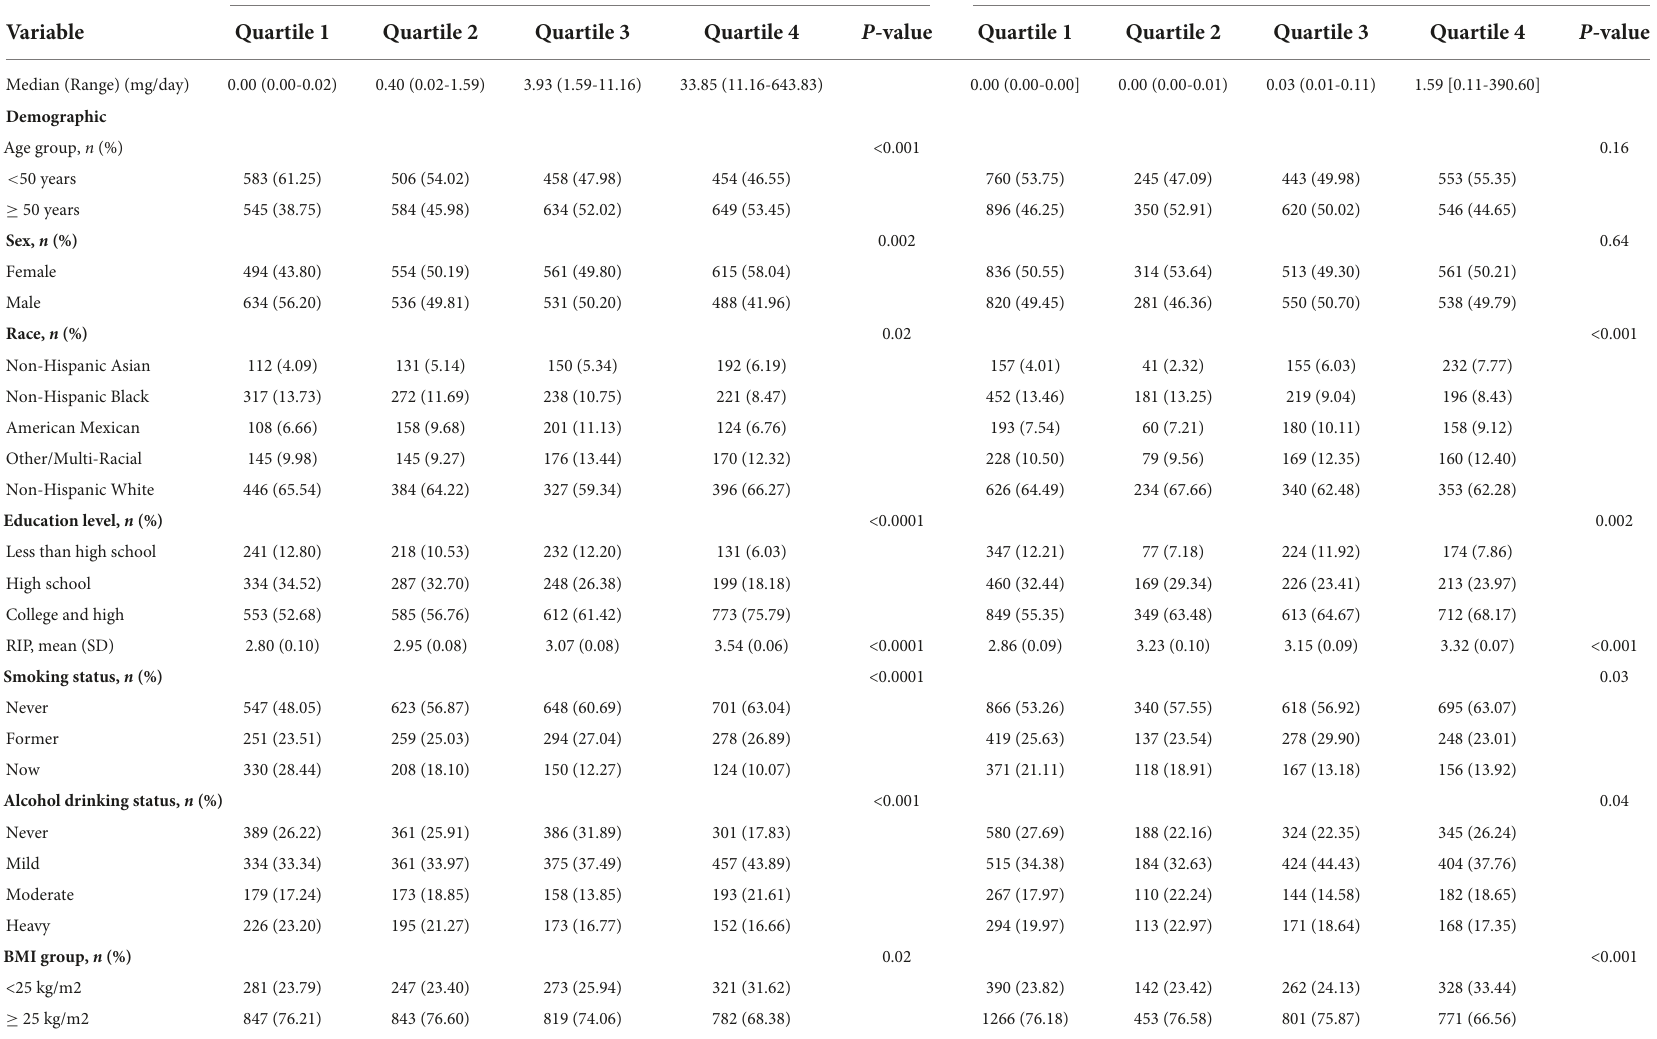
TABLE 2 The weighted association between anthocyanidin and isoflavone intake and other